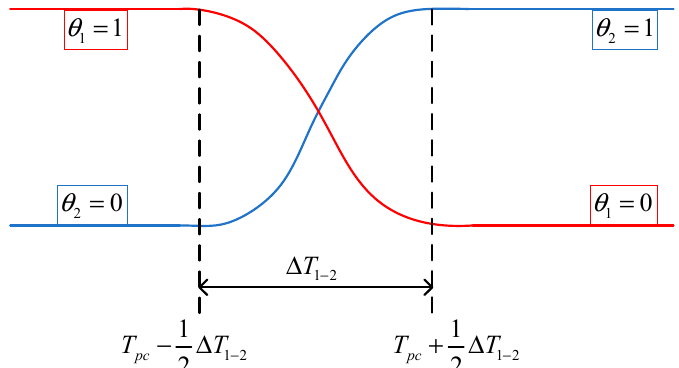
Figure 1. Schematic diagram of latent heat of phase transformation.